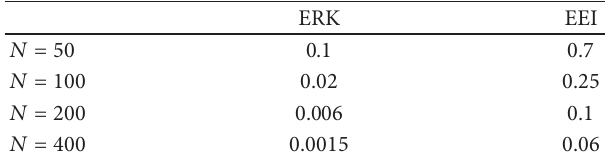
Table 3: The stability comparison of ERK method and EEI method. ERK